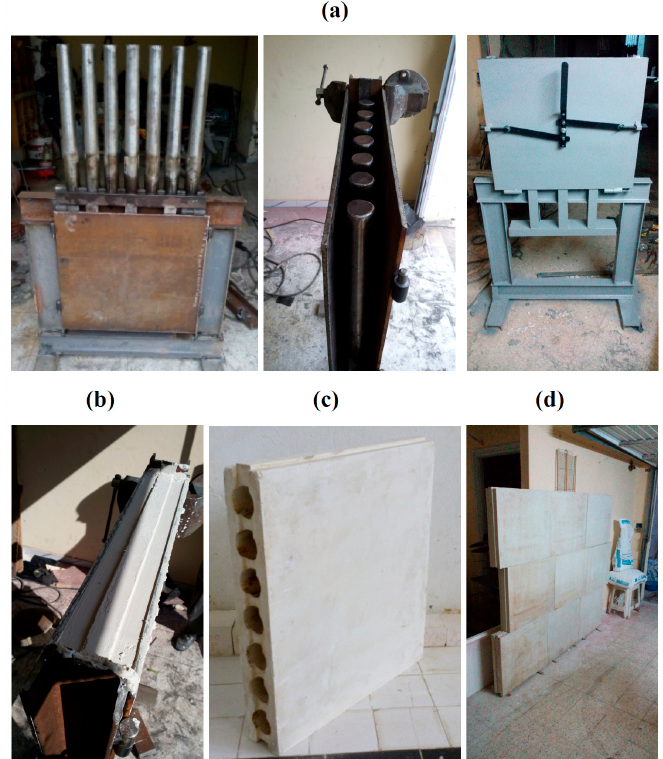
Figure 15. The block prototype manufacturing process: ( a ) Preparation of the steel mold, ( b ) Mold casting, ( c ) Blocks removing, ( d ) On air block drying